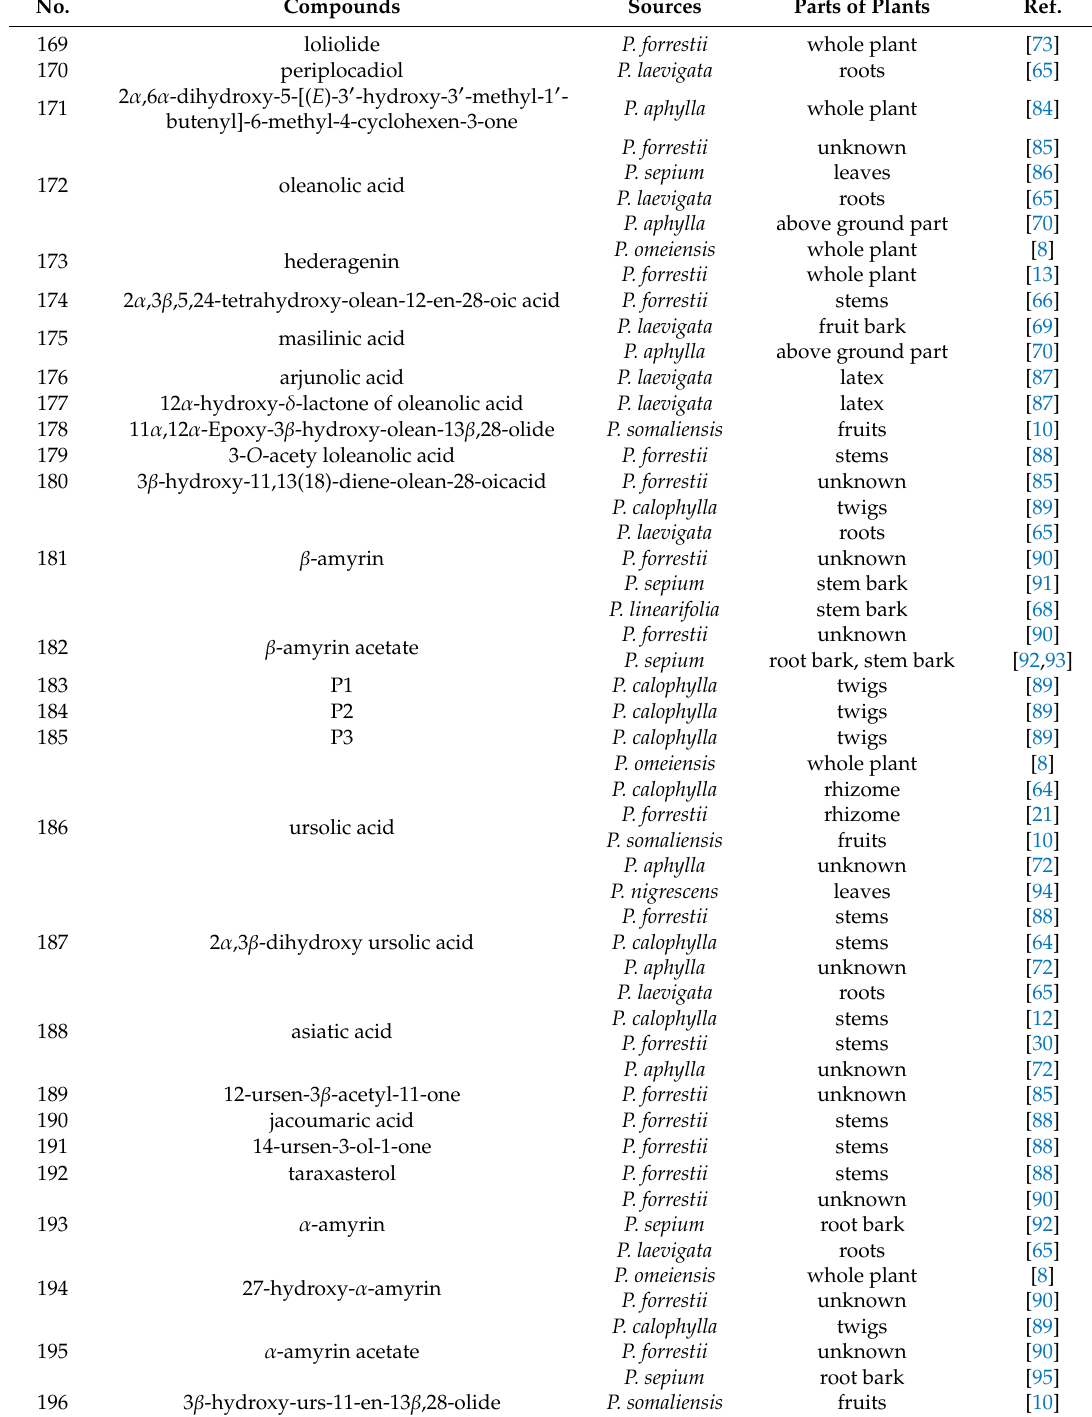
Table 4. Terpenoids from the genus Periploca